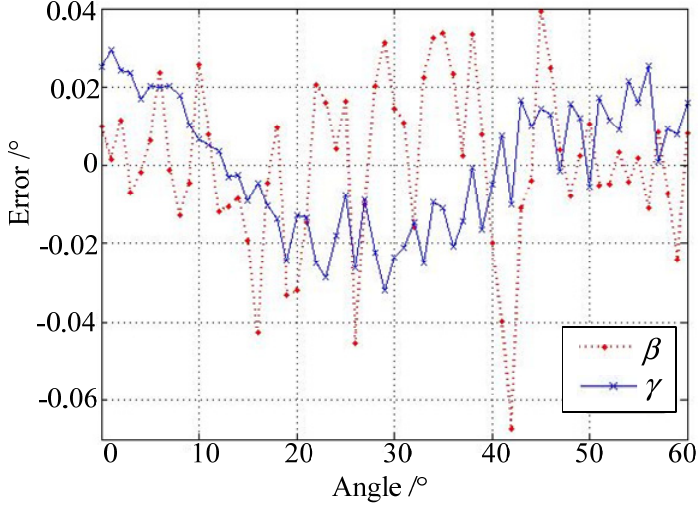
Figure 13. Measurement error statistics of sun sensor performance test.